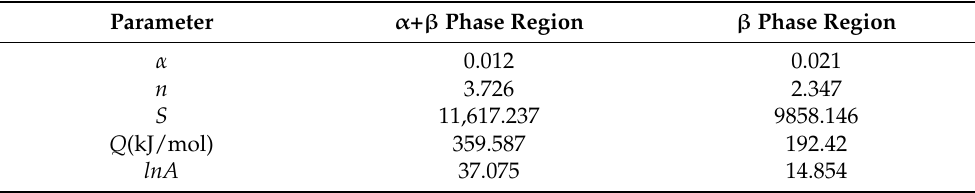
Table 6. Parameter values of hyperbolic sine equation at strain